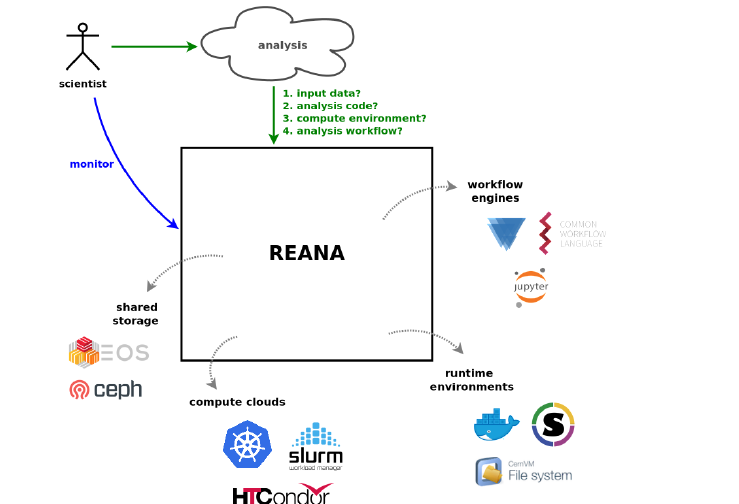
Figure 1. A schematic representation of REANA platform taking user inputs, code, environment and workflow defintion for executing analysis pipeline using various workflow systems (such as CWL [3] and Yadage [4]) on various compute backends (such as Kubernetes, HTCondor, Slurm).